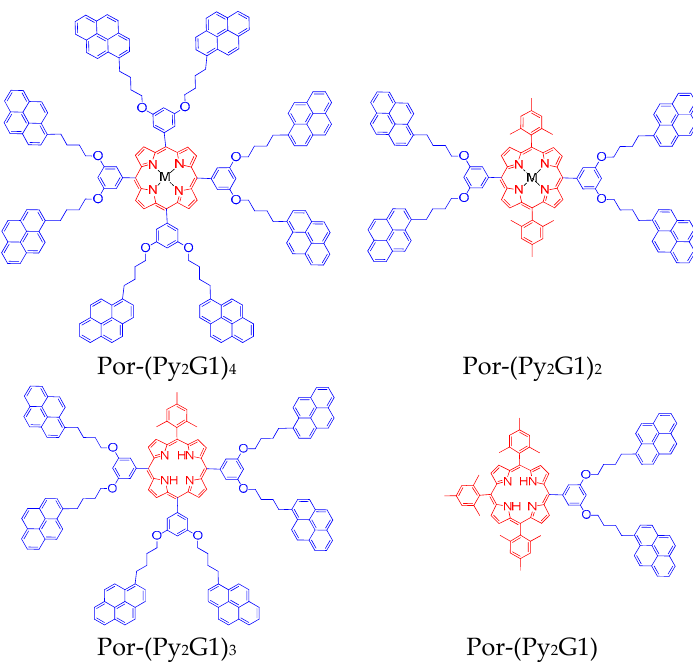
Figure 4. Structure of the dendrimers bearing first-generation pyrene-labelled Fréchet-type dendrons and a porphyrin core [66].